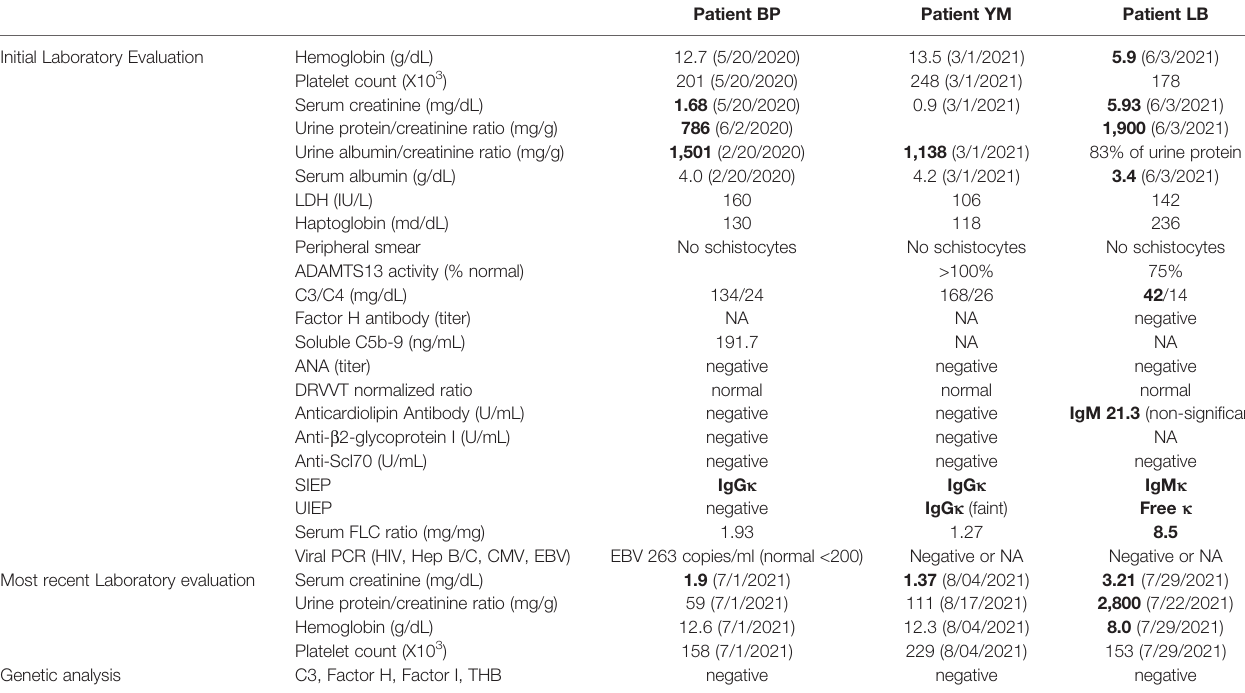
ANA, antinuclear antibody; CMV, cytomegalovirus; DRVVT, dilute Russel viper venom time; EBV, Epstein-Barr virus; FLC, free light chain; LDH, lactate dehydrogenase; NA, not available; PCR, polymerase chain reaction; SIEP, serum immuno fi xation electrophoresis; THB, thrombomodulin; U, units; UIEP, urine immuno fi xation electrophoresis. Bolded values are abnormal, all others are within normal